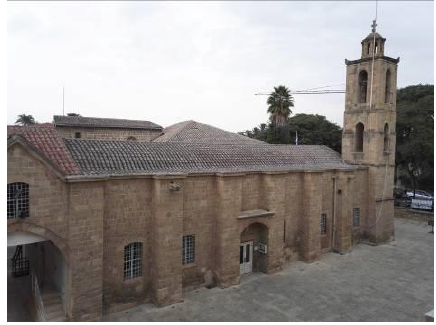
Figure 2. Northen façade with the bell